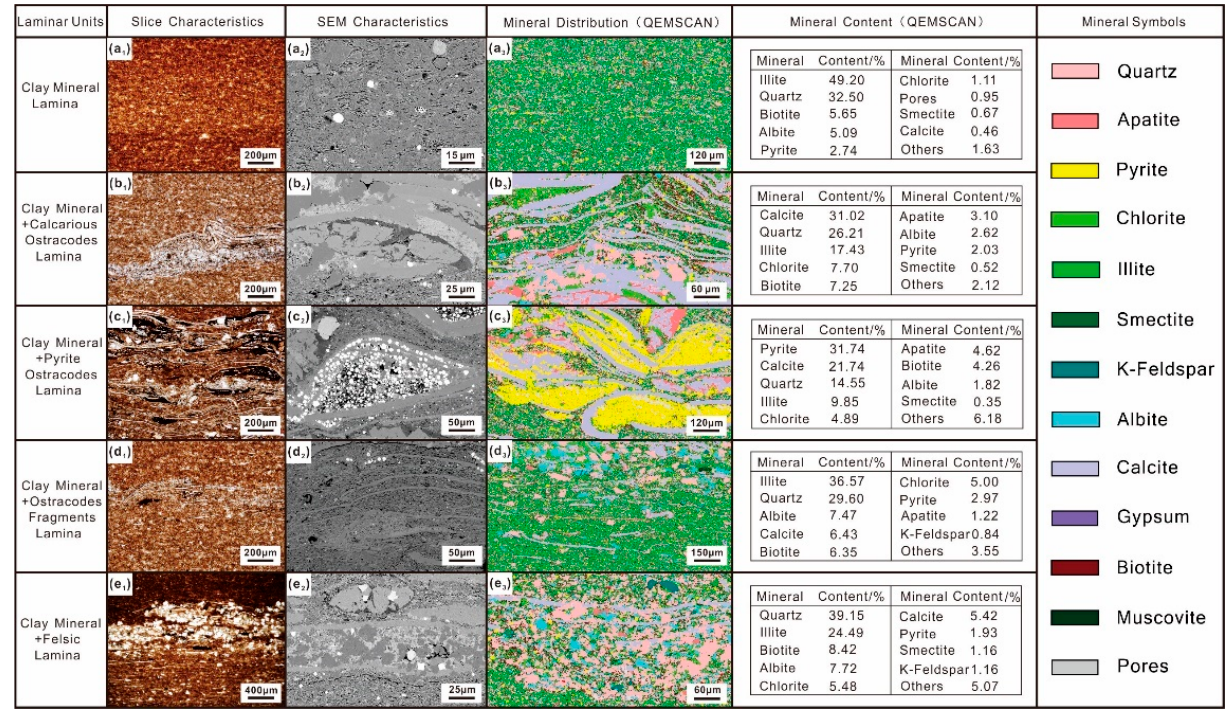
Figure 3. Mineral type and composition of different laminar units.